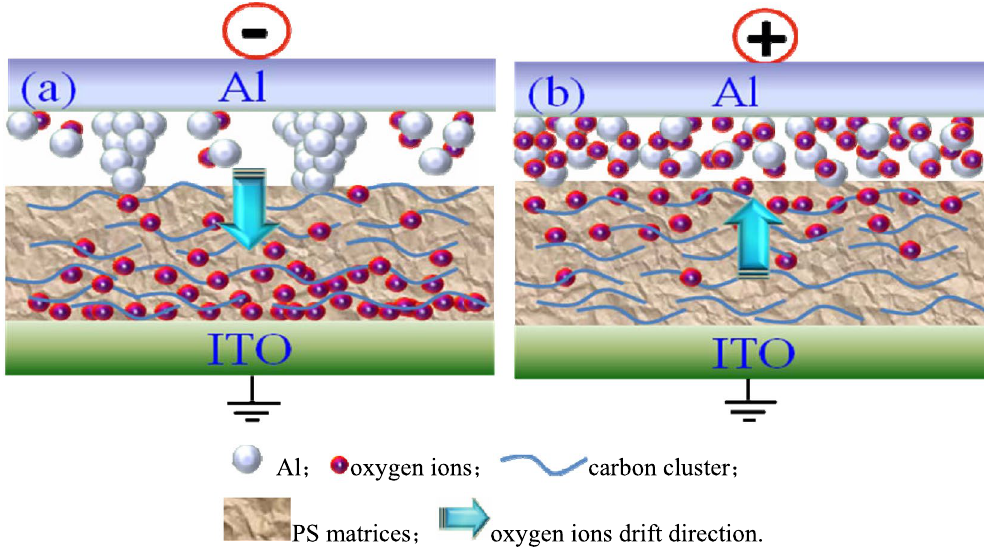
Figure 10. Schematic diagram of the resistive switching model for ITO/PS + GO/Al device. ( a ) The negative bias was applied; ( b ) The positive bias was applied.